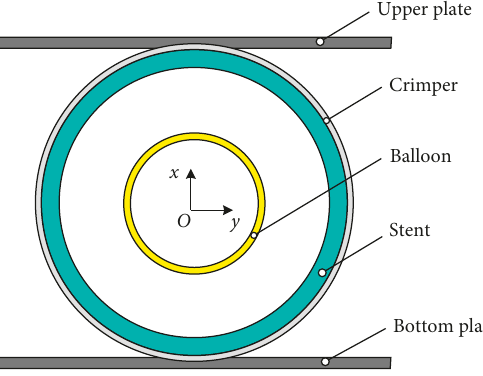
Figure 7: Schematic of stent crimping, expansion, and planar compression